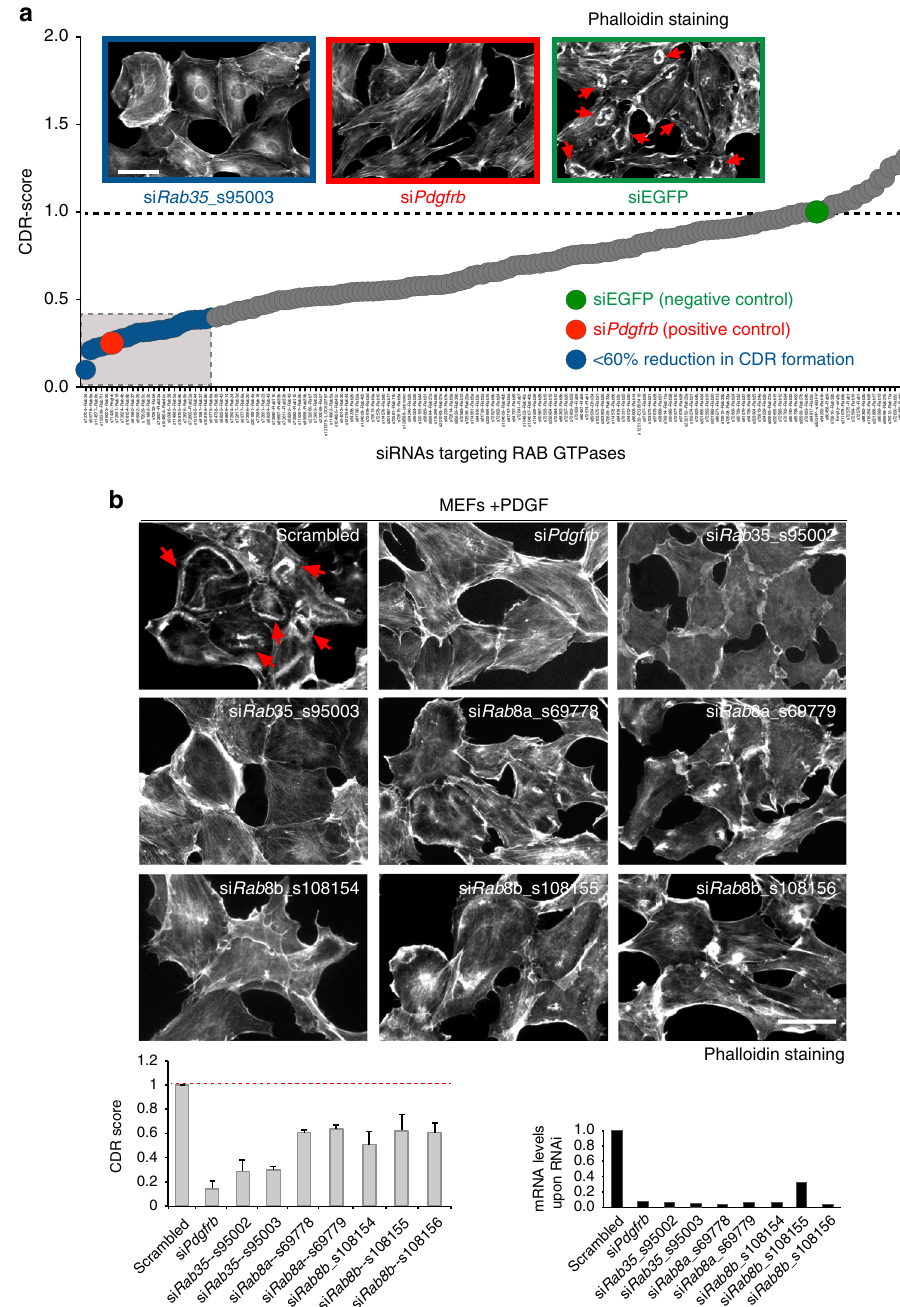
Fig. 1 siRNA screening for RAB GTPases involved in CDRs formation. a siRNAs targeting RAB GTPases were ranked according to their CDR score (Methods and Supplementary Figure 1). Representative images of positive (si Pdgfrb ) and negative (siEGFP) controls are, respectively, in red and green. siRNAs best inhibiting CDR formation (more than 60% reduction relative to scrambled siEGFP) are enclosed into the light grey box. The oligo s95003 targeting Rab35 , indicated in blue, is reported as a representative example. Red arrows indicate CDRs. Scale bar, 50 μ m. b The siRNAs that inhibited CDRs formation more ef fi ciently were validated in a completely independent experiment. Left: MEF cells interfered for Rab35 (ID: s95002, s95003), or Rab8a (ID: s69778, s69779), or Rab8b (ID: s108154, s108155, s108156), Pdgfrb (positive control), or Scrambled oligo (negative control). Upon PDGF stimulation, cells were fi xed and stained with phalloidin. Representative images are shown for each experimental condition. Red arrows indicate CDRs. Scale bar, 50 µ m. Right: CDRs were manually counted and normalized against scrambled-transfected, control samples. Data are the mean ± SD ( n > 200 cells/condition in three independent experiments). The silencing of the targeted genes was veri fi ed by